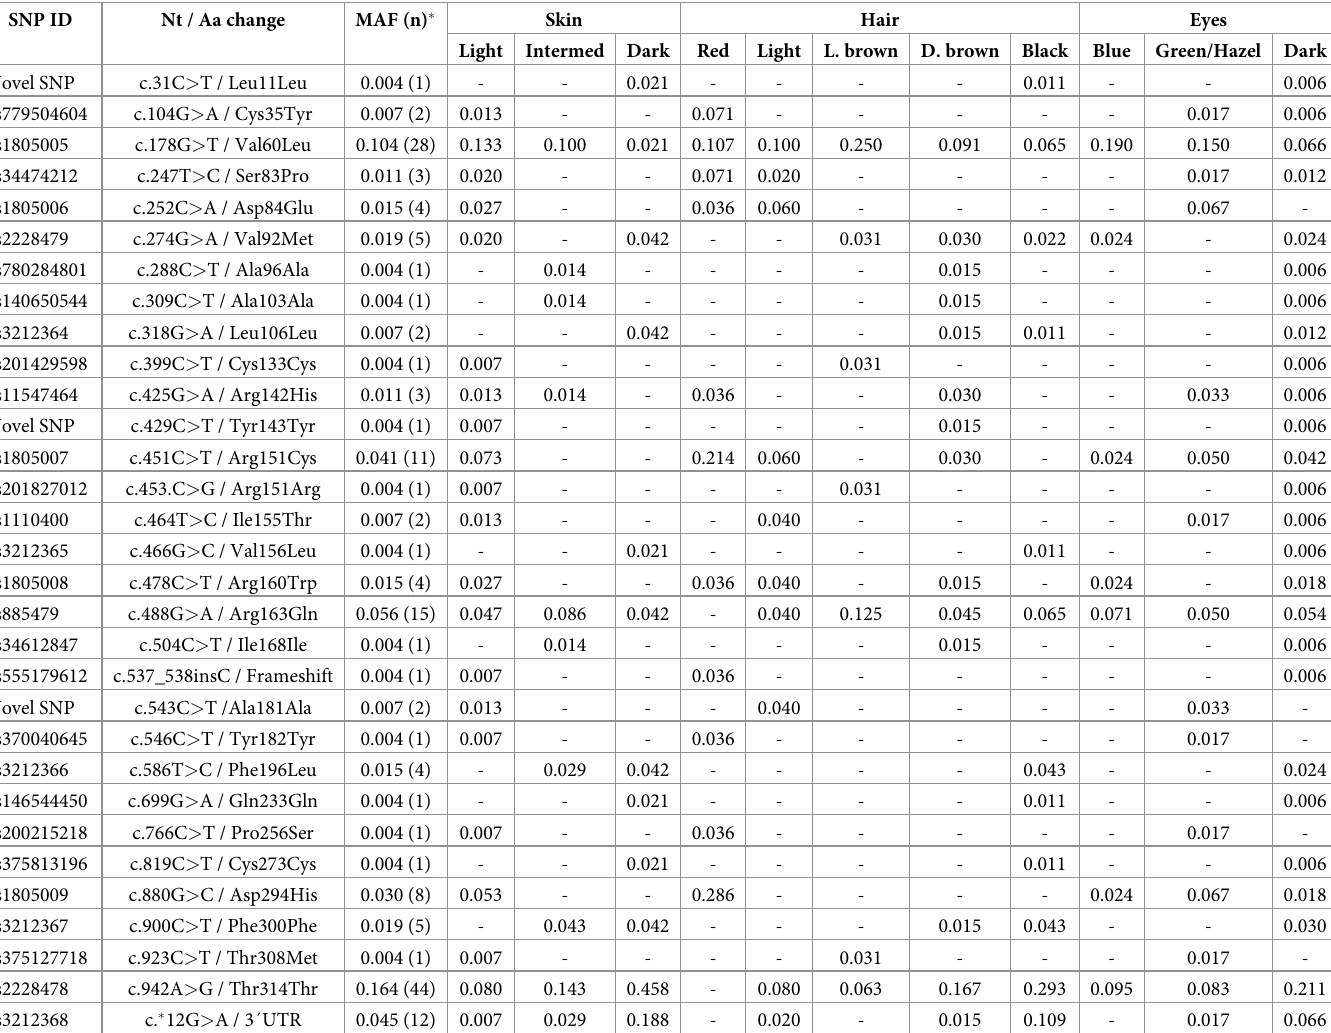
Table 2. Minor allele frequency (MAF) of MC1R polymorphisms from RJ